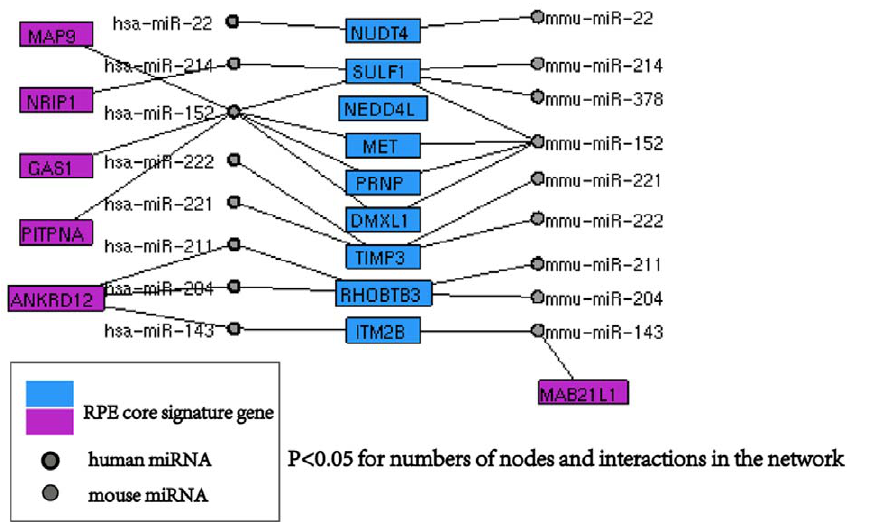
Figure 4. Human-mouse RPE miRNA interaction network for assembly of RPE signature genes. The network shows human-mouse RPE miRNA shared RPE signature genes, blue nodes are only targeted by one specie, purple nodes are shared by two